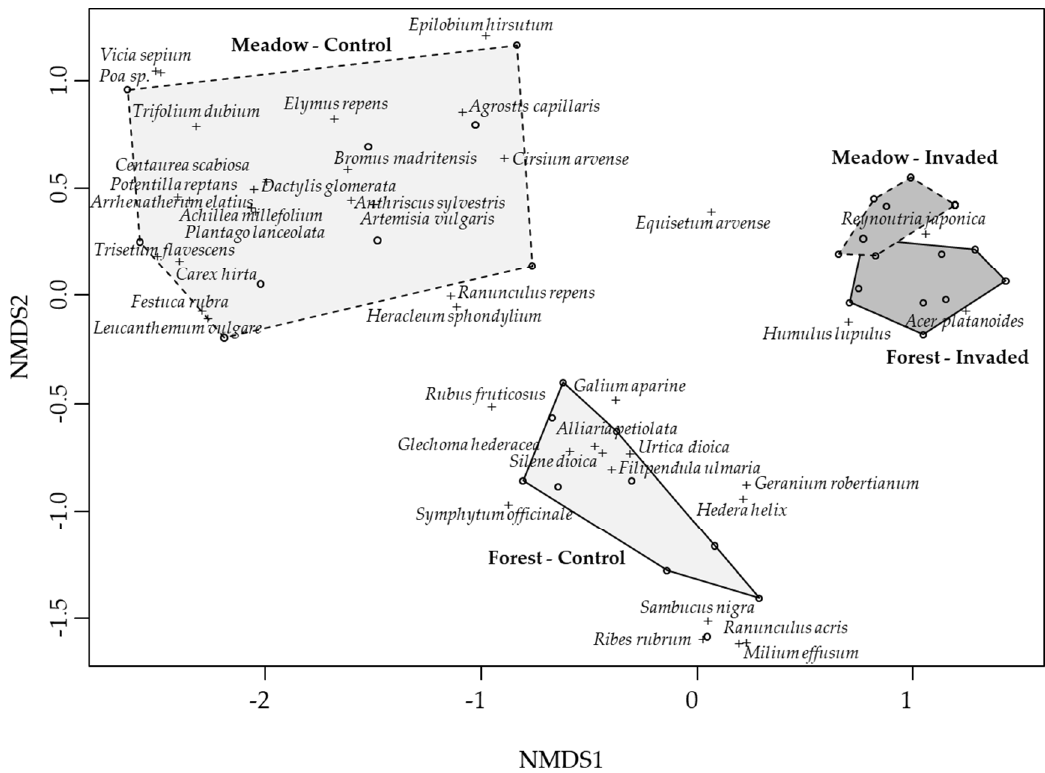
Figure 2. Non-metric multidimensional scaling (NMDS) (stress = 0.11) performed on the plant community composition. The 9 samples of each treatment are grouped in polygons, with dashed lines for the meadow sites and full lines for the forest sites (control plots in light grey and invaded plots in dark grey). Dots represent the 36 quadrats and crosses represent the spatial location of each species. For clarity, only the plant species most correlated to the two first axes are shown.